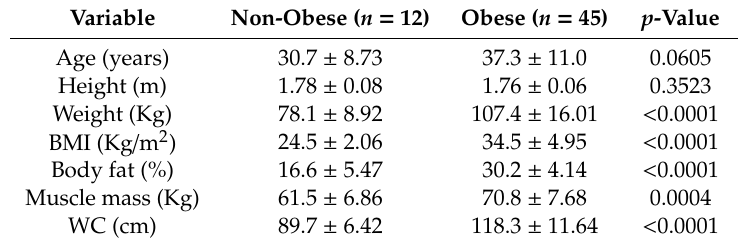
Table 6. Anthropometrics characteristics for the obese and non-obese group according to waist circumference. Variable